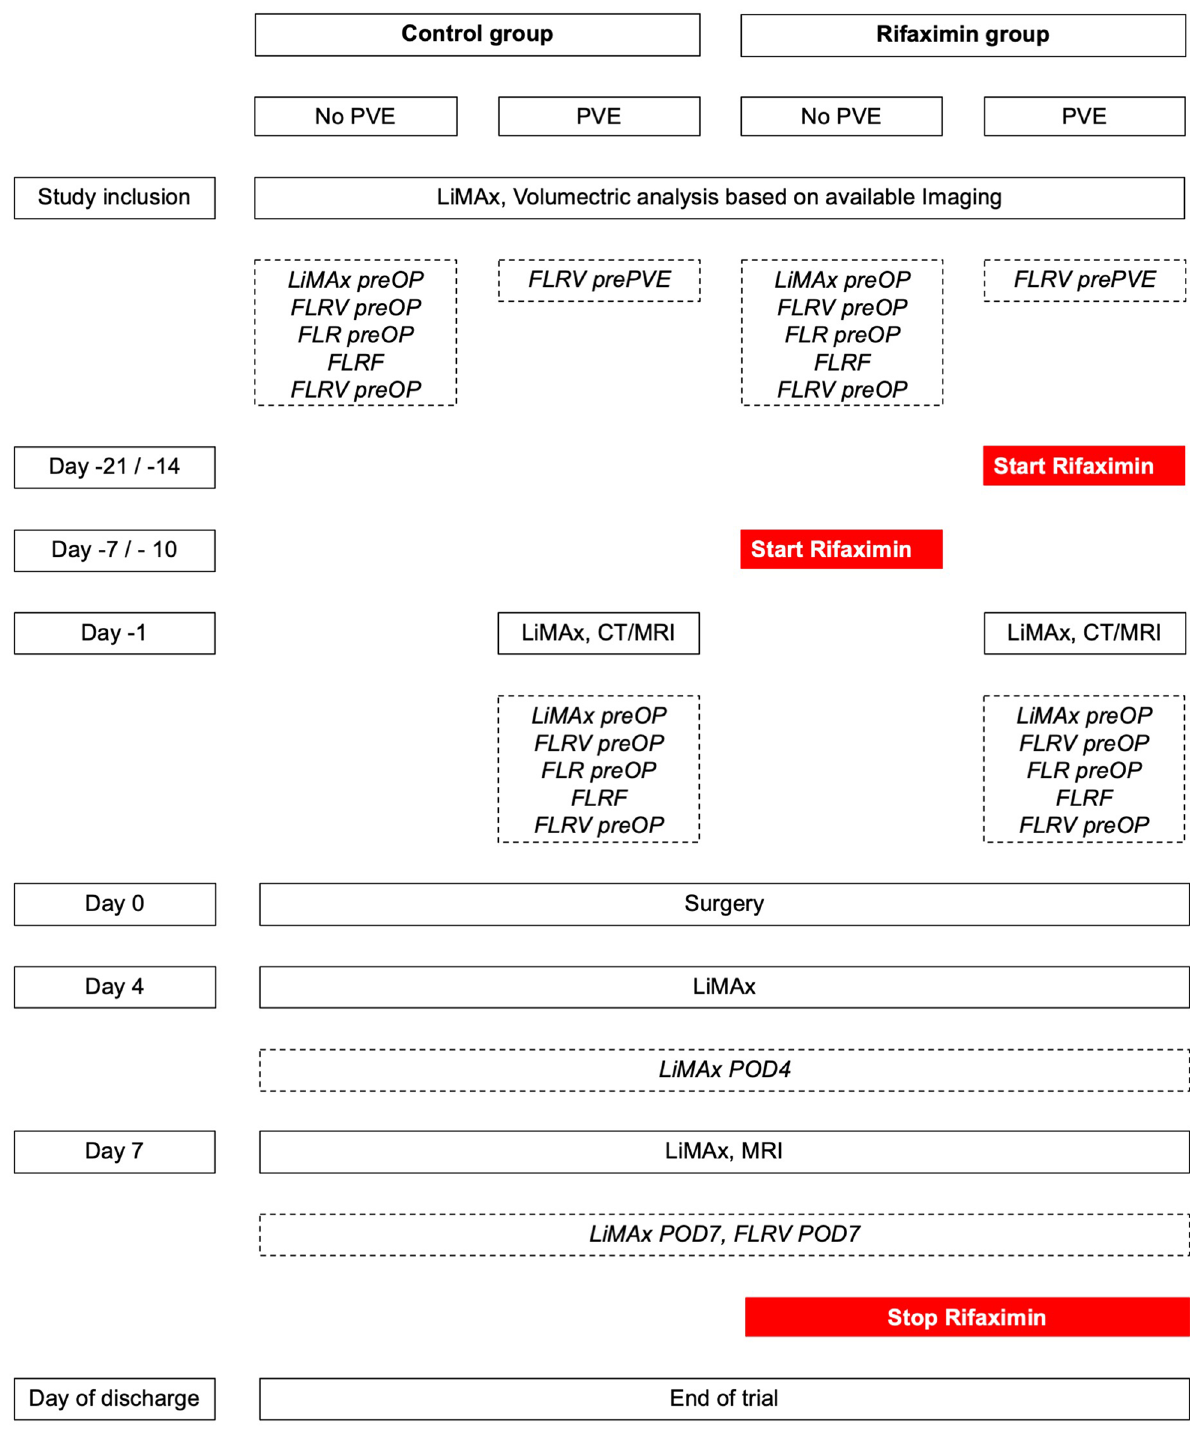
Figure 1. Trial overview. A reduced overview of the trial and all included study visits. Study events and tests are depicted in continues rectangles and measured variables with importance for statistical analysis in dashed rectangles. FLRF, future liver remnant function; FLRV, future liver remnant volume; LiMAx, maximum liver function capacity; MRI, Magnetic resonance imaging; POD, postoperative day; prePVE, prior to PVE; preOP, prior to surgery; PVE, portal vein